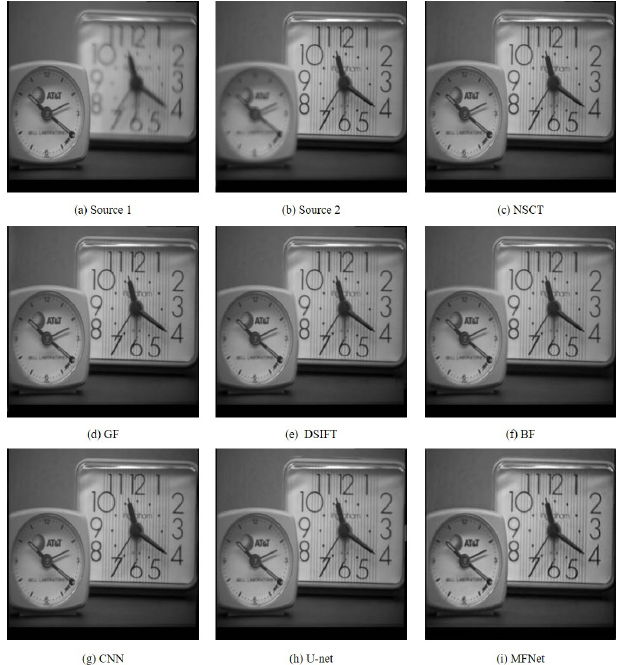
Figure 3. The “Clock” source image pair and their fused images obtained with different fusion methods.